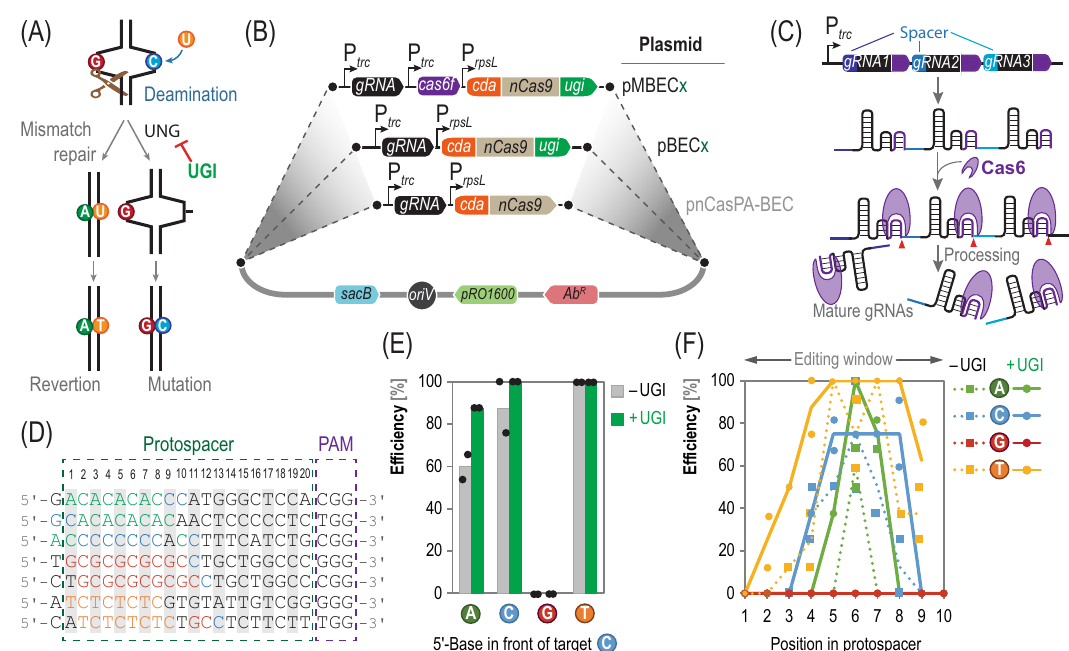
Fig. 2 Tailoring a cytidine base editor for multiplex genome modi fi cations in P. putida . A Upon cytidine deamination, the paired guanidine is converted to adenine and thymidine, or uridine is recognized by uracil-DNA glycosylase ( UNG ), an activity blocked by the UNG inhibitor ( UGI ). B Incorporation of ugi to editing plasmids (pBEC) towards increasing editing ef fi ciency. In a subsequent step, cas6f was introduced for processing multiple gRNAs (pMBEC).